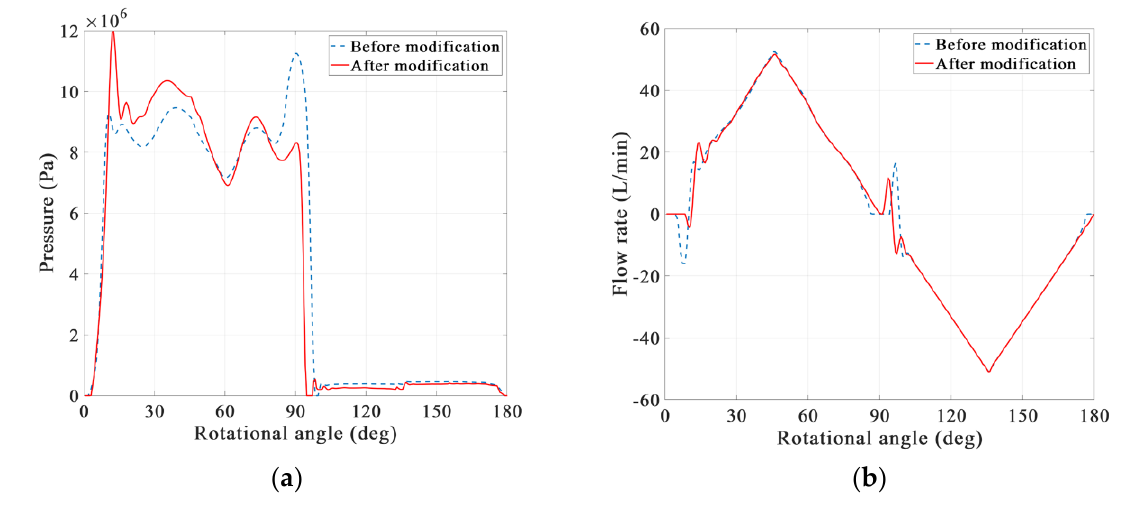
Figure 19. Comparisons of ( a ) chamber pressures and ( b ) outlet and inlet flows.